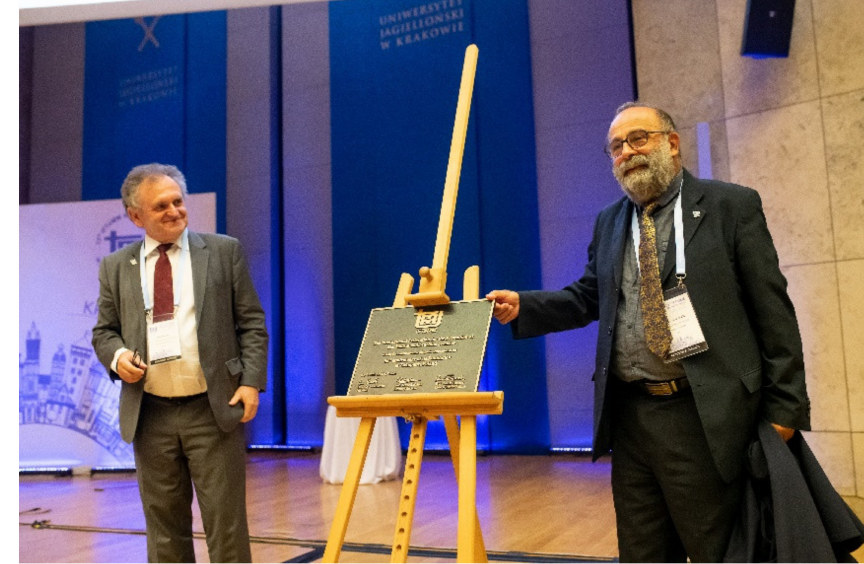
Figure 4. The revealing act of the bronze commemorative